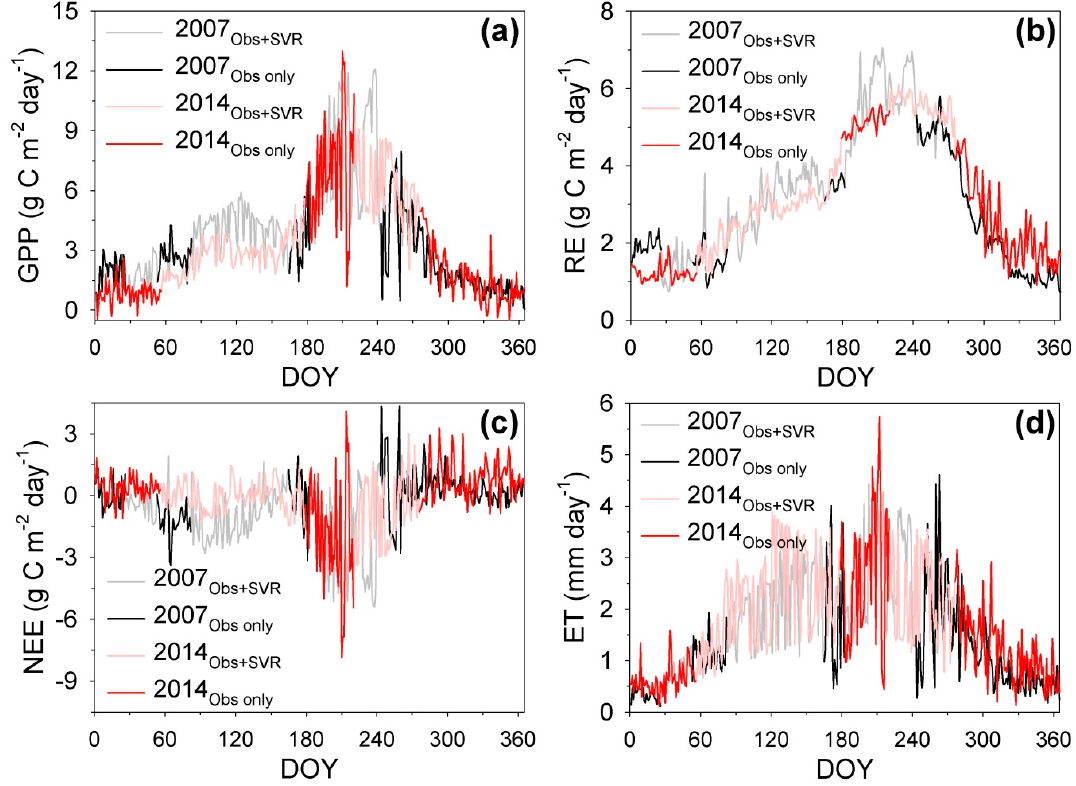
Figure 10. Time series of the GPP ( a ), RE ( b ), NEE ( c ), and ET ( d ) at the study site in 2007 and 2014 from the observational data only (Obs only) and the gap-filled data using the SVR-based model (Obs + SVR).